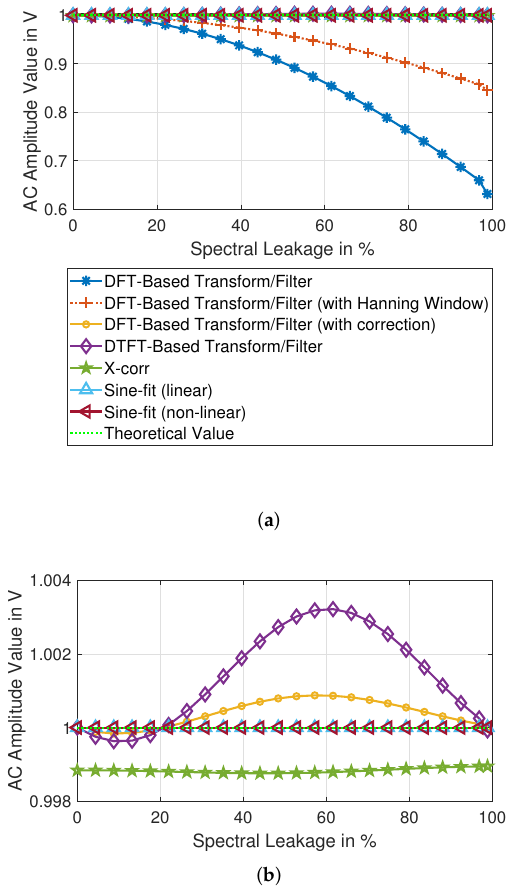
Figure 4. ( a ) Full Comparison of the Different Signals. ( b ) A Zoom into the most Precise Methods.